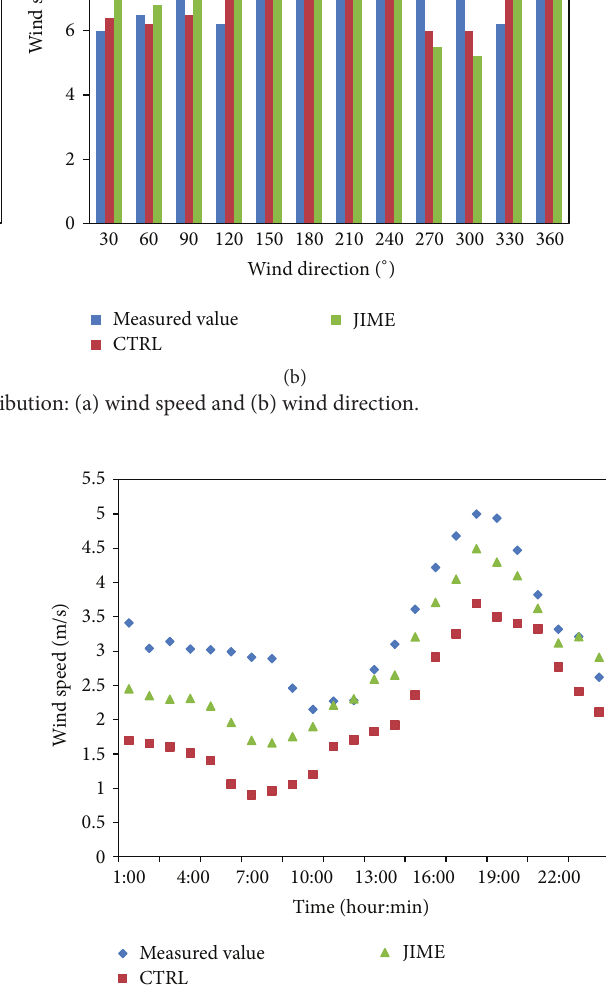
Figure 8: Mean hourly wind speed at Arou station in